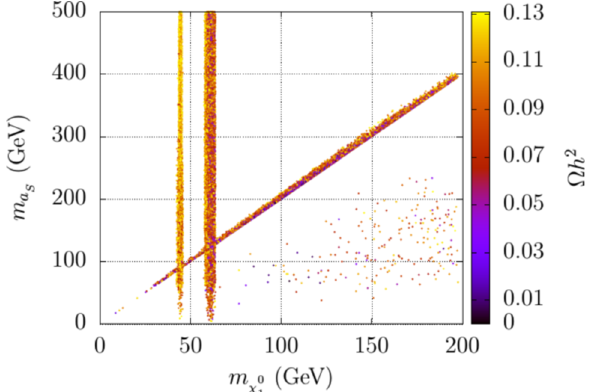
-funnel S – m plane with a χ 0 1 S